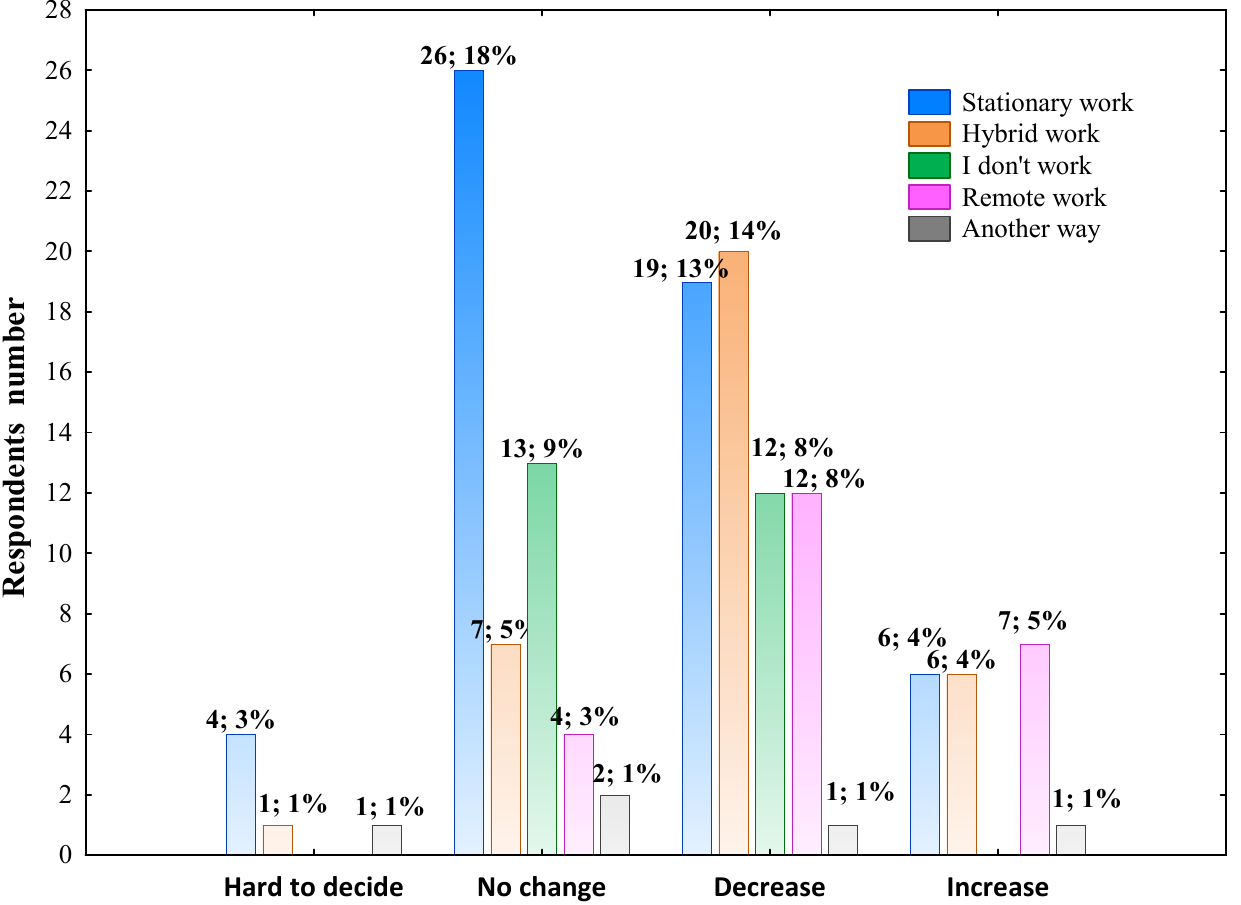
Figure 6. The effect of the COVID-19 pandemic on physical activity change according to the professional work mode. The column description includes the respondents’ number who declared the effect or no effect of the pandemic on changing physical activity, followed by the percentage of the total respondents. Data were analyzed using Pearson’s chi-squared test. Pearson’s χ 2 = 26.850; df = 12; p = 0.00812; n=144.